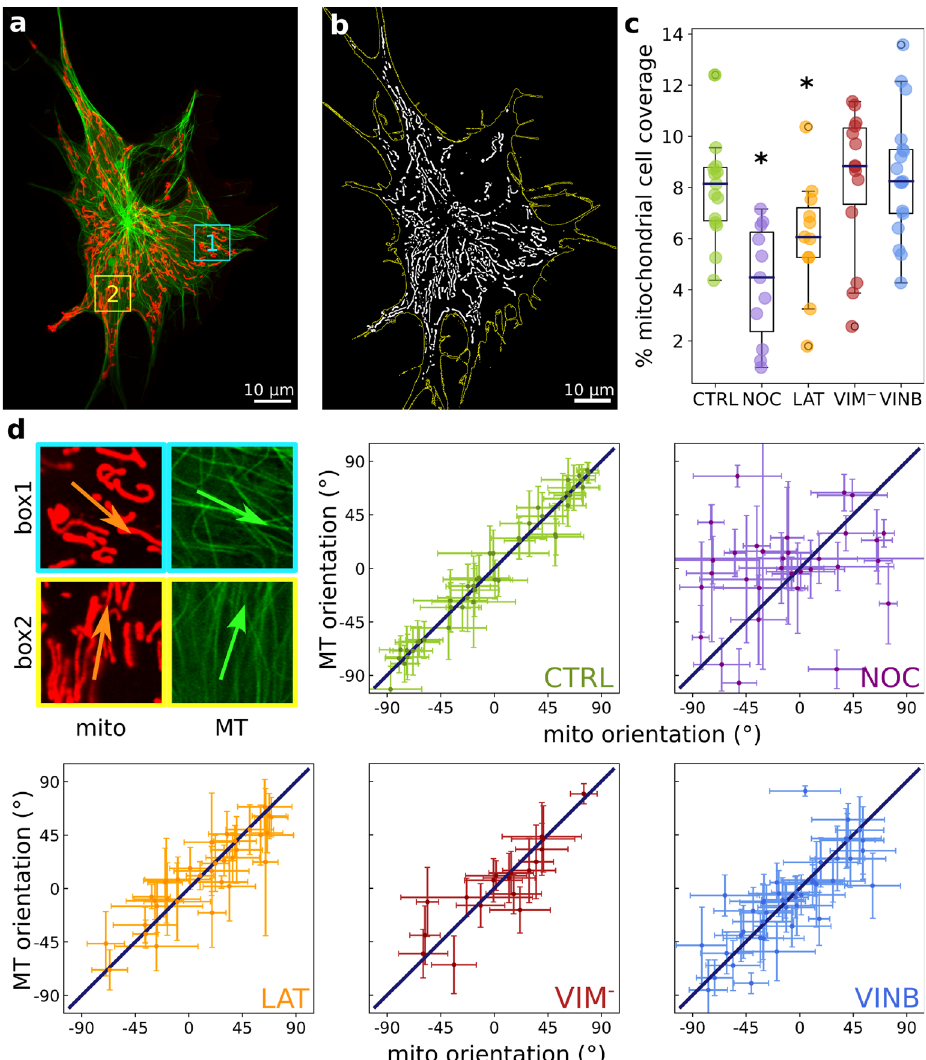
Figure 1. Dependence of mitochondrial network on the cytoskeleton integrity. ( a ) Representative Airyscan-SR image of X. laevis melanocyte expressing EGFP-XTP (green: microtubules) and incubated with MitoTracker Deep Red FM (red: mitochondria). ( b ) Binary image of the mitochondria network obtained for the cell shown in ( a ). The yellow line indicates the cell contour estimated as described in Supplementary Section 4. ( c ) Quantification of the mitochondrial cell coverage. Measurements were performed in control cells (CTRL), cells incubated with nocodazole (NOC), latrunculin-B (LAT) or vinblastine (VINB) and cells − expressing the dominant negative vimentin mutant mCherry-(vim(1-138)) (VIM ). Each circle represents a single cell. Asterisks denote significant differences (p-value < 0.05) with respect to the control condition. The values obtained are specified in Supplementary Table S2. ( d ) Mitochondria and microtubule orientation analysis. Zoom-in images of the regions included in the squares (box 1–2) delimited in the cell shown in ( a ). Mitochondria (mito) and microtubules (MT) images were analyzed independently to compute the local orientation angle (arrows) within the same subcellular region. Both magnitudes were plotted and compared through a linear regression routine as described in